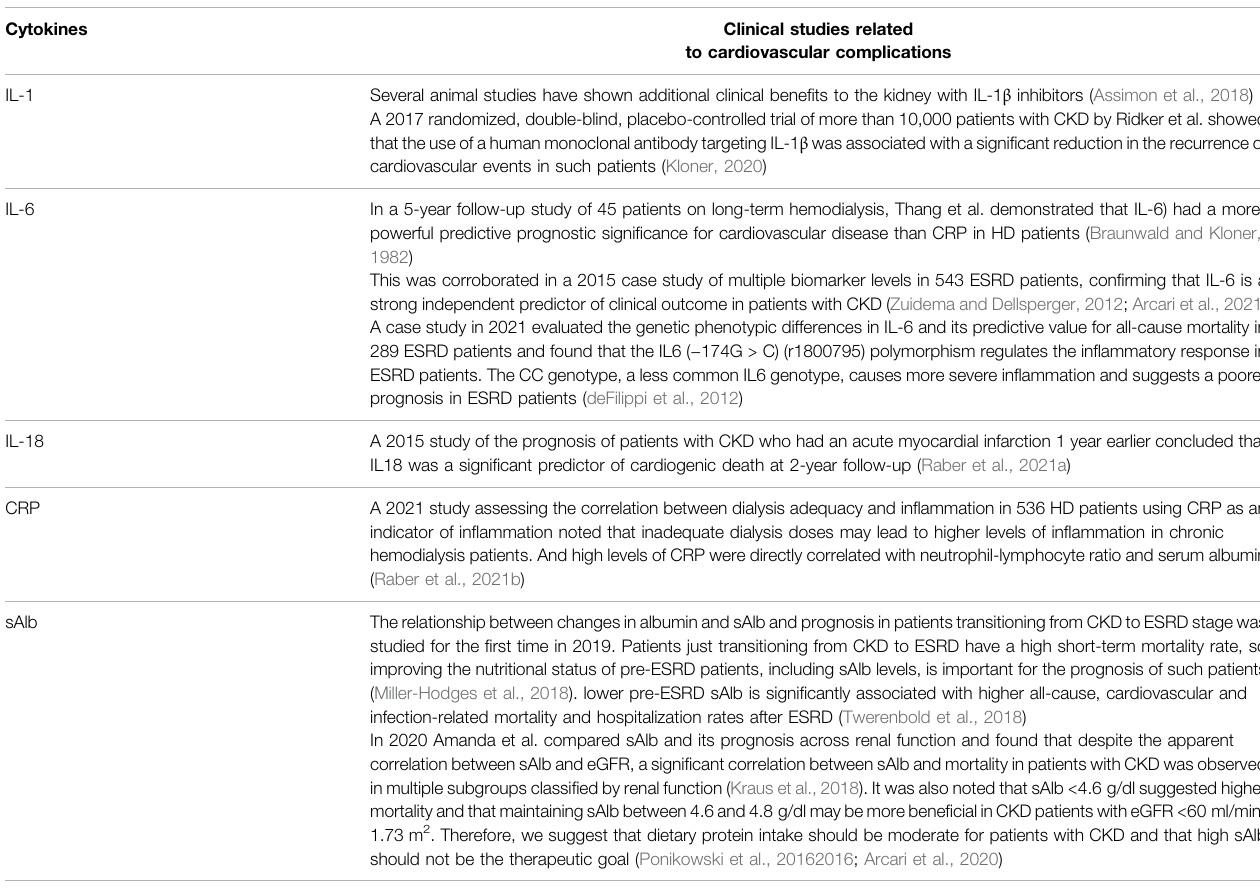
TABLE 2 | A recent study of common in fl ammatory factors associated with cardiovascular complications in hemodialysis patients.